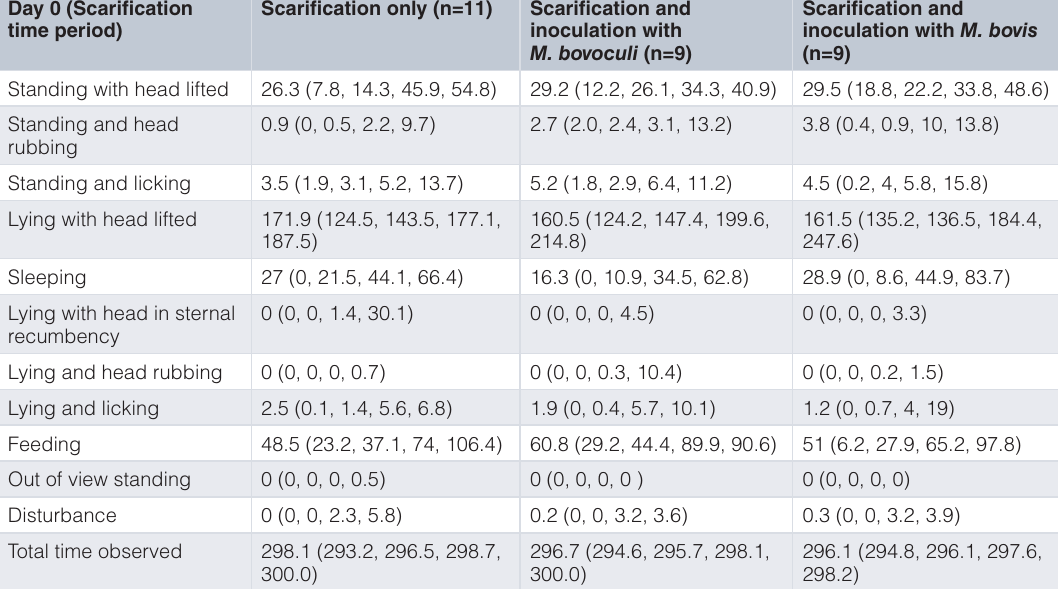
Table 4. Median, (minimum, 25 th quartile, 75 th quartile, maximum) values for duration of behavioral states in minutes by treatment during scarification time period (n = number of